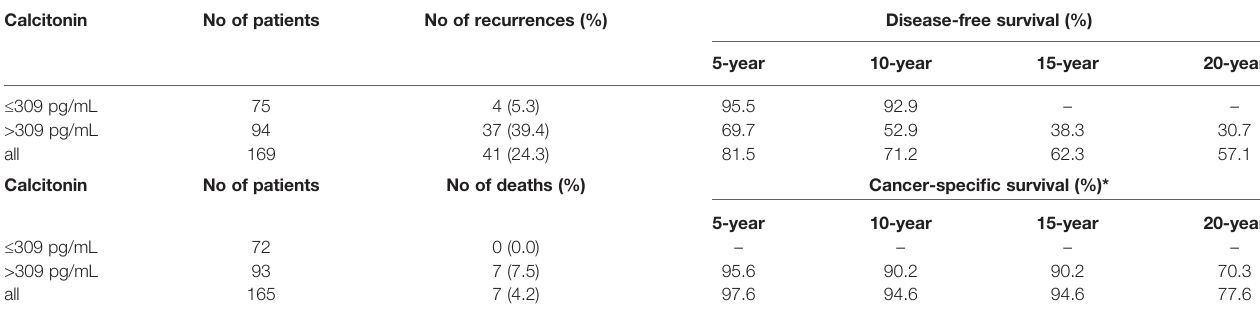
TABLE 3 | Disease-free survival and cancer-speci fi c survival according to the preoperative serum calcitonin cut-off value of 309 pg/mL. Calcitonin